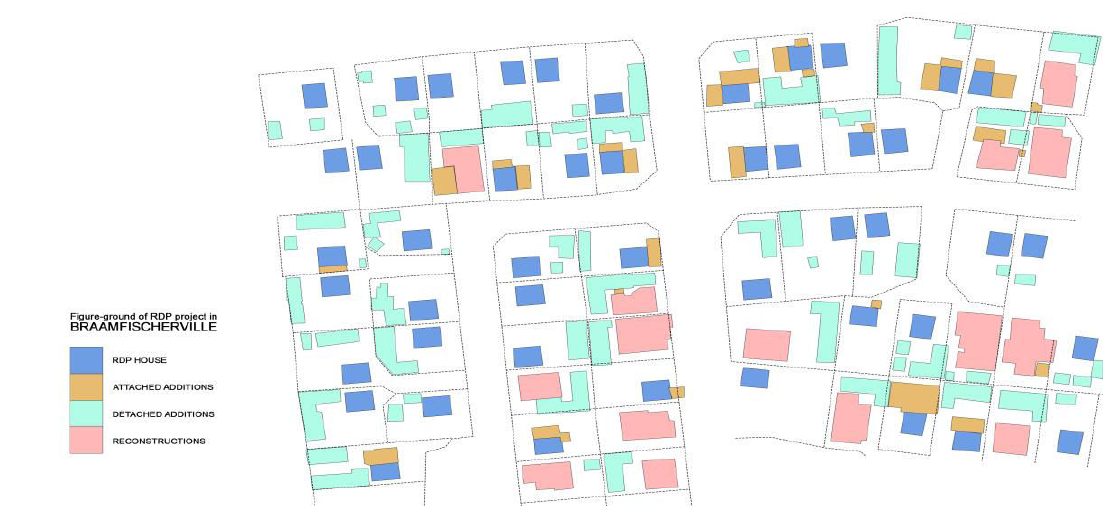
Figure 1: Figure-ground of Braamfischerville illustrating occupant construction. By author,